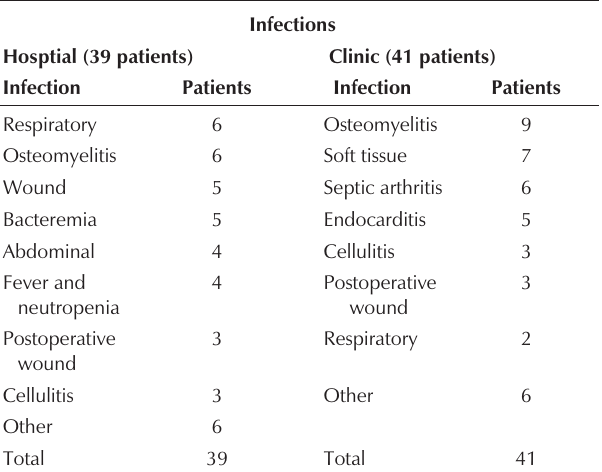
Sample of patients managed by Infections Limited,